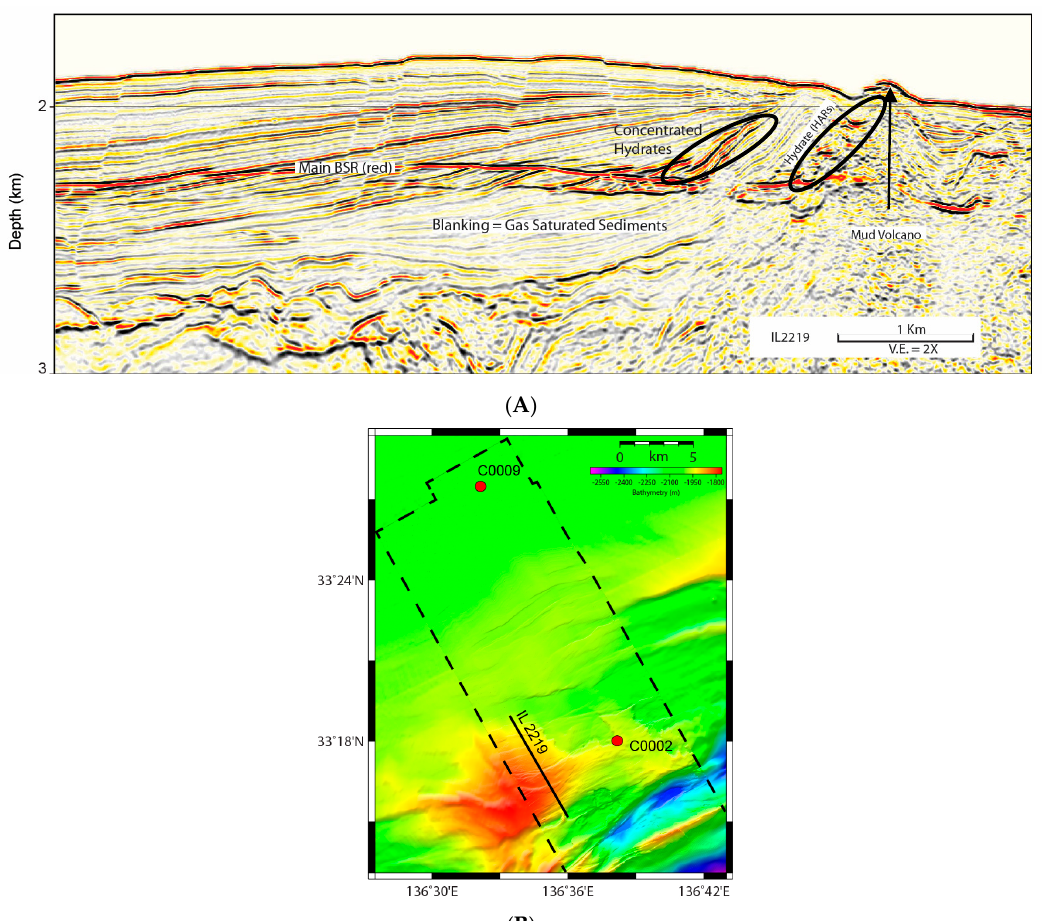
Figure 12. ( A ) Seismic IL 2219 HARs above the BSR (circled) are associated with underlying gas migration routes, strong main BSR, and zones of blanking beneath the BSR. We interpret the circled regions to host highly concentrated gas hydrates. The main-BSR is not offset across the deep cutting normal faults and there are no pockmarks in the seafloor bathymetry. The mud volcano breaches the seafloor and lacks a BSR suggesting it is likely active or recently active. ( B ) Bathymetric map of the study zone with the extent of IL 2219 shown for reference.